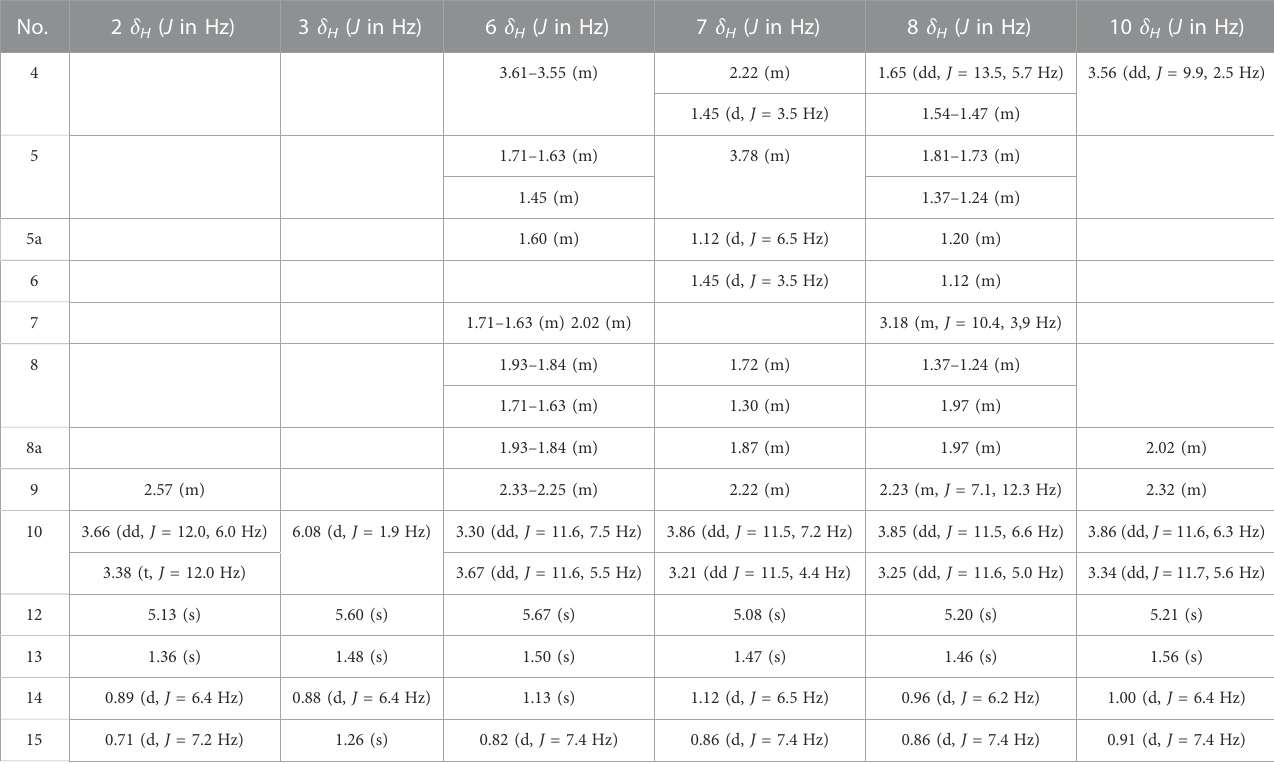
TABLE 2 1 H-NMR spectral data ( δ ) for compounds 2 , 3 , 6 – 8 , and 10 .